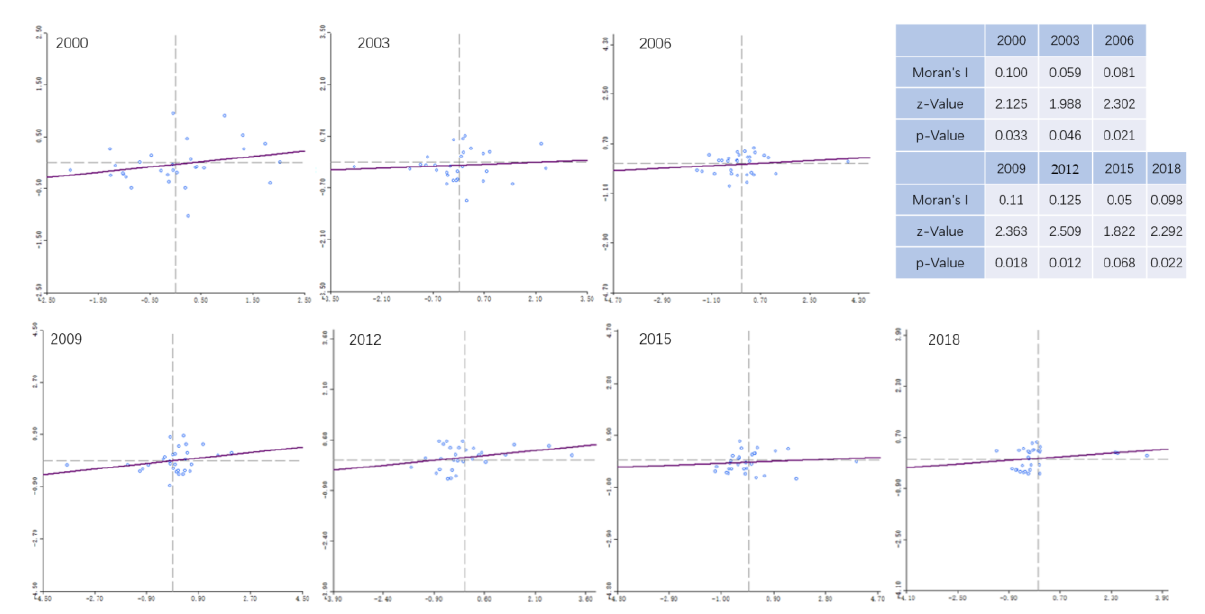
Figure 13. Moran’s I statistics for the tertiary industry income growth rate (TIIGR).